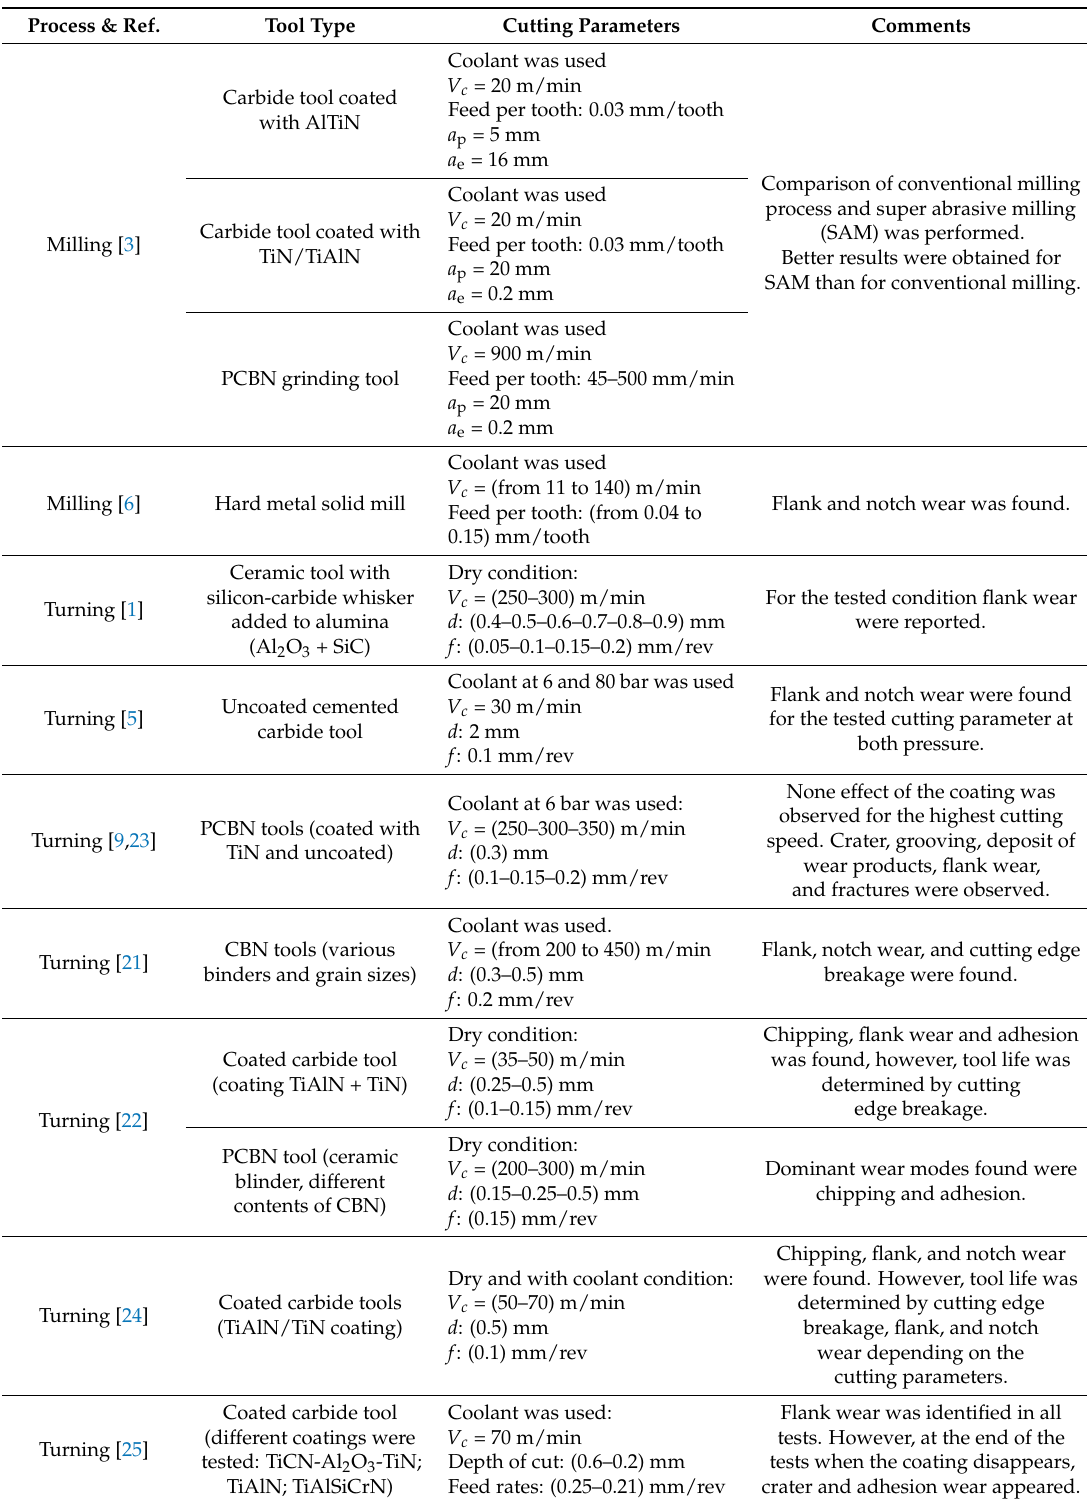
Table 1. Summary of the most common type of tool used to machine Inconel 718. Process &